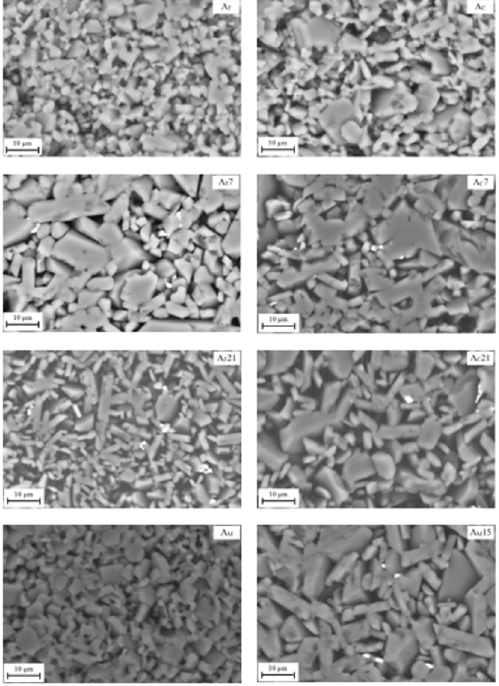
Figure 11. SEM observations of the alumina ceramics and LZSA/ alumina composites: etched specimens.